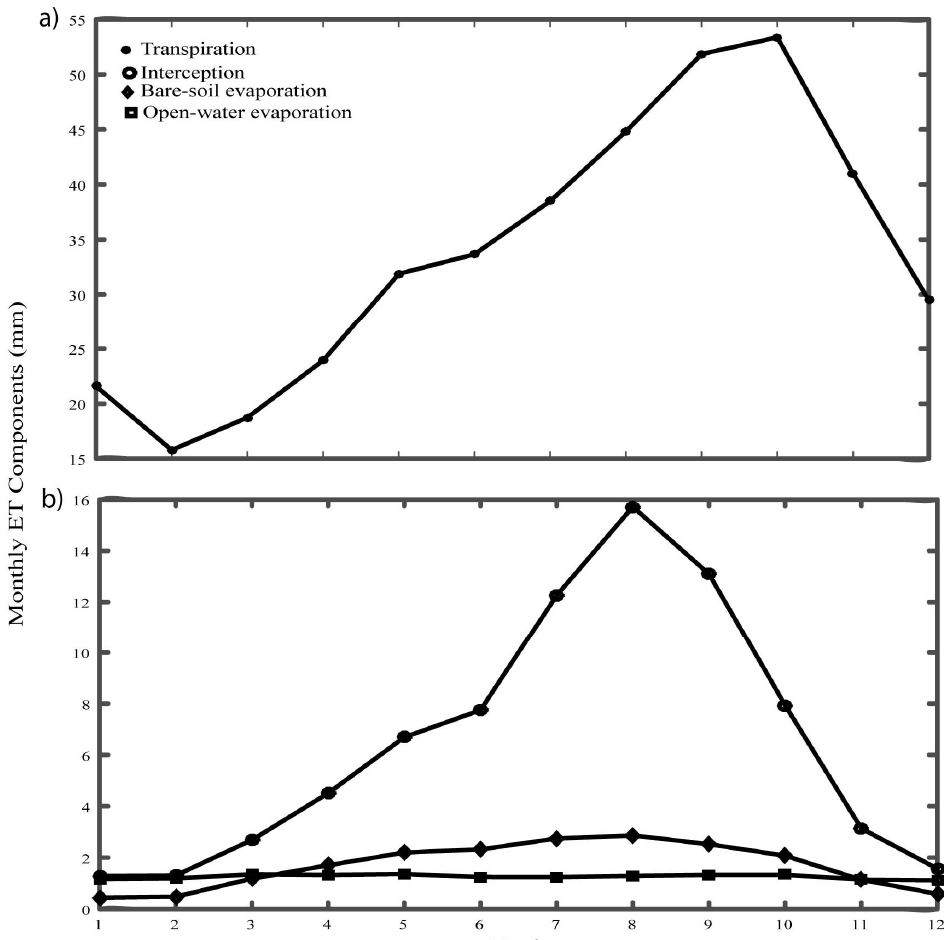
Figure 9. Monthly amounts of different ET components in the Nile Basin during the study period of 1980–2014: ( a ) E t , and ( b ) E i , E b , and E w .